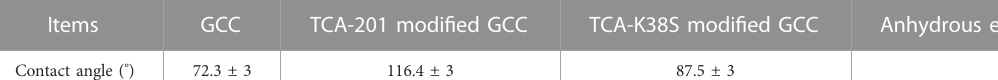
TABLE 7 The contact angle of different contact angle.